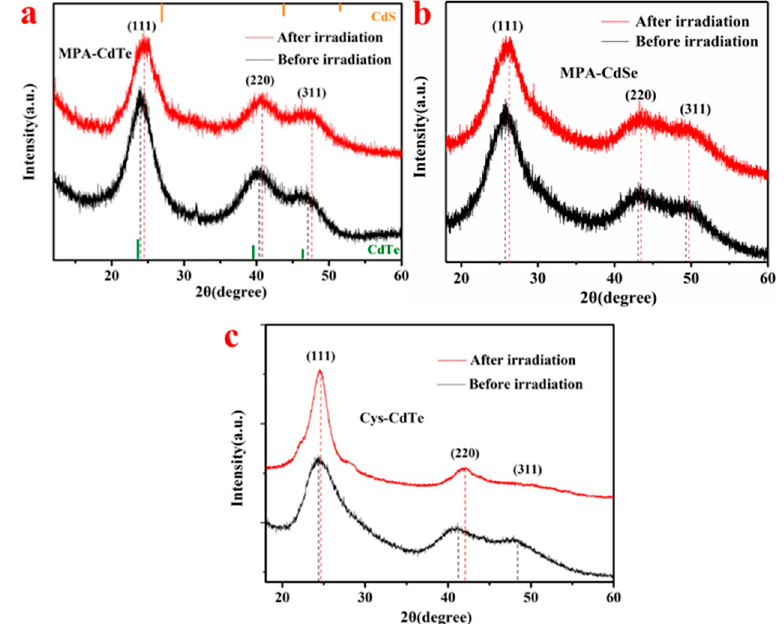
Figure 6. XRD patterns of MPA-CdTe ( a ), MPA-CdSe ( b ) and Cys-CdTe ( c ) QDs before and after 10 kGy γ -irradiation.